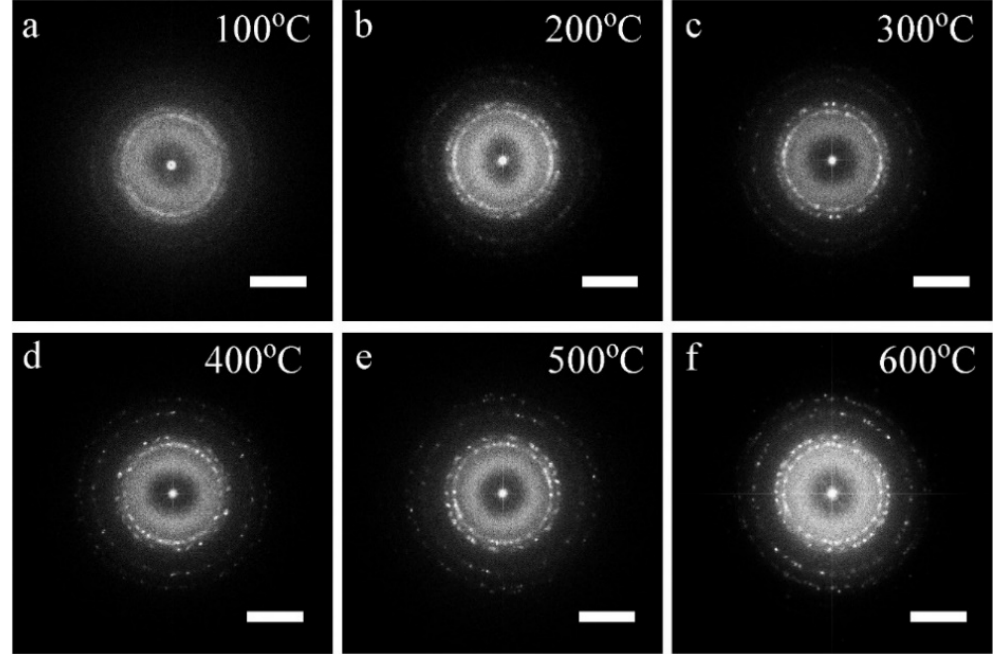
Figure 5. The Fast Fourier Transform (FFT) patterns extracted from HREM images in Figure 2. As the increasing of temperature, the polycrystal rings become more and more clear as shown in Figure 5 ( a – f ). At high temperature, some discrete spots can be found due to the growth of Pt nanograins. Scale bars, 5 1 / nm.